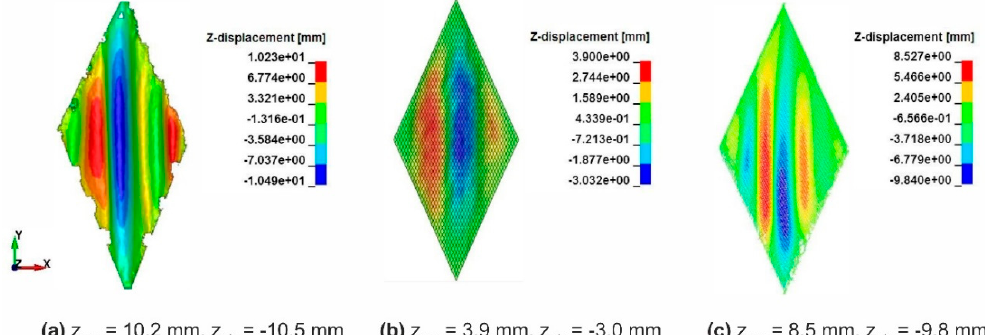
Figure 13. Optical comparison of the wrinkle size of fabric variant 2 at 40° shear angle: ( a ) One representative sample from experimental tests, ( b ) simulation result from macro-scale model, ( c ) simulation result from meso-scale model.